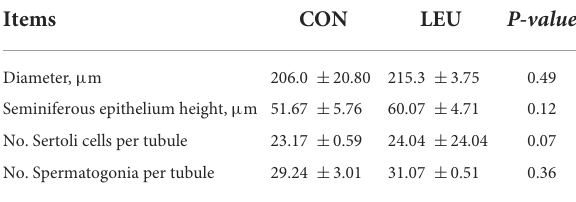
TABLE 6 Effects of dietary leucine supplementation on plasma membrane integrity, acrosome integrity and mitochondrial membrane potential in boar